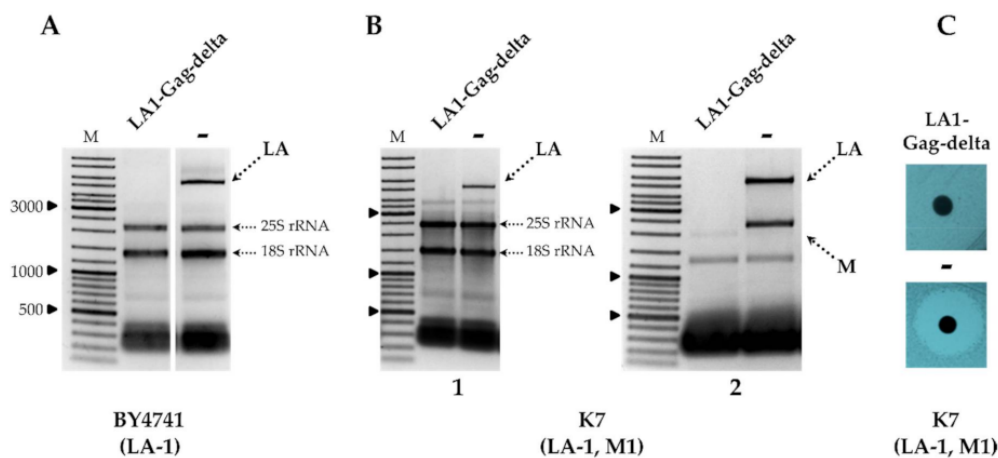
Figure 1. The impact of LA1-Gag-delta overexpression on the maintenance of LA and M dsRNAs. ( A ) Agarose gel electrophoresis of total RNA isolated from the BY4741 strain; LA1-Gag-delta is the sample of the strain transformed by truncated LA-1 Gag protein expression vector, − is the control sample. ( B ) Agarose gel electrophoresis of total RNA (1) and dsRNA (2) isolated from K7 strain transformants. ( C ) Killer phenotype assay of K7 yeast strain transformant. M column is the molecular size marker (GeneRuler DNA Ladder Mix, Thermo Scientific, Vilnius, Lithuania); yeast strains with corresponding genotypes are indicated below the